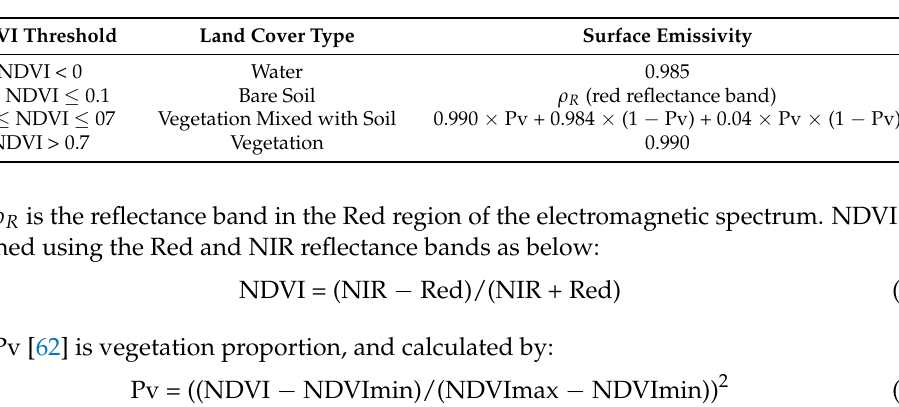
Table 4. Surface emissivity values assigned based on NDVI thresholds.